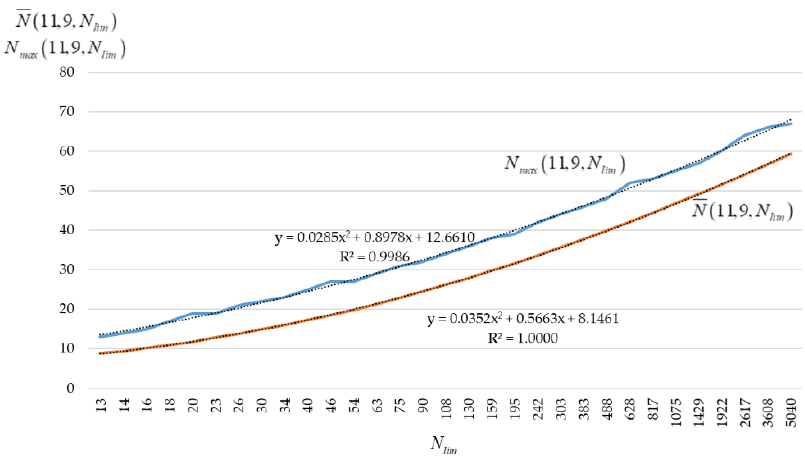
Figure 9. Graphs N ( 11,9, N lim ) and N max ( 11,9, N lim ) when ∆ = 0.04.